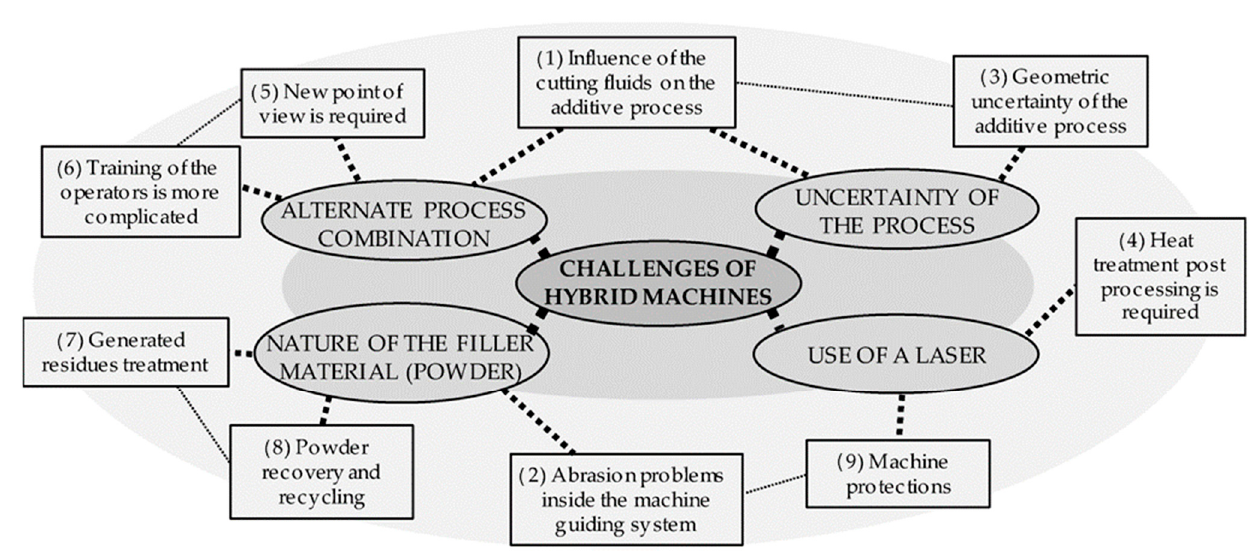
Figure 11. Schematic figure illustrating the challenges of hybrid machining. Reproduced from [100]. MDPI Open Access Information and Policy: https://www.mdpi.com/openaccess; accessed on 21 October 2022.